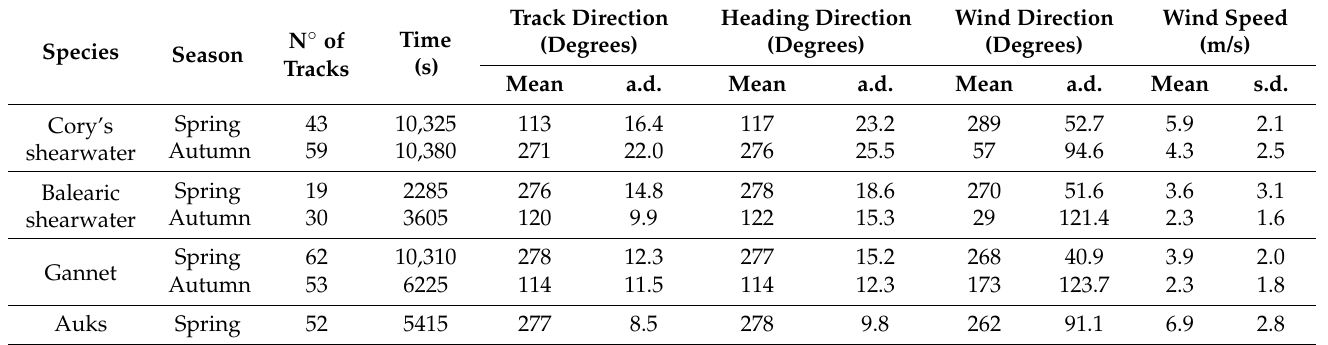
Table 2. Radar data for migrating seabirds identified species by different seasons. The number of tracks, mean, and scatter (s.d.—standard deviation, a.d.—angular deviation) of direction (track direction, heading direction and wind direction) of migrating birds, and wind speed. Time refers to the total tracking time per species and season.